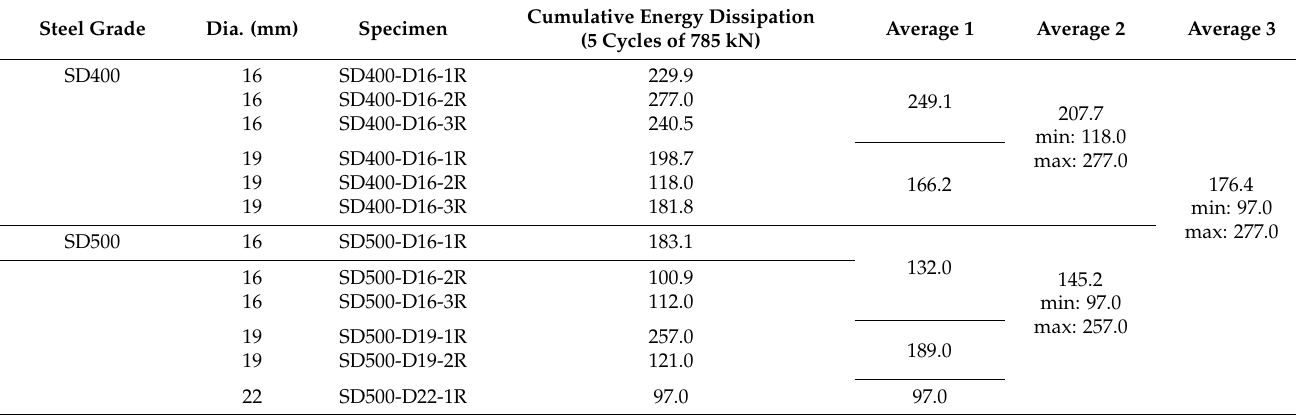
Table 13. Energy dissipation according to transverse rebar type (repeated load = 785 kN) (unit = kN · mm). Steel Grade Dia.